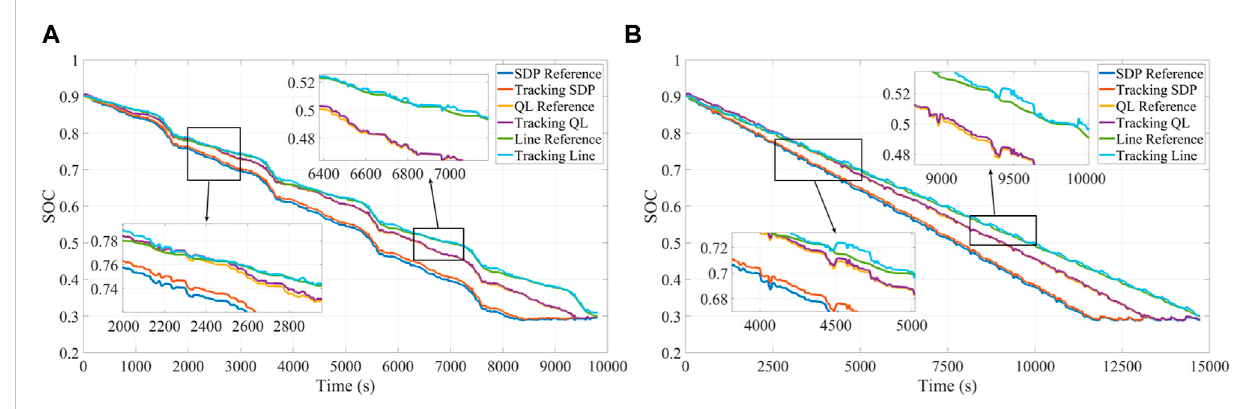
FIGURE 15 SOC curves under different reference trajectories: (A) 5 KM1. (B) 12 KM2.